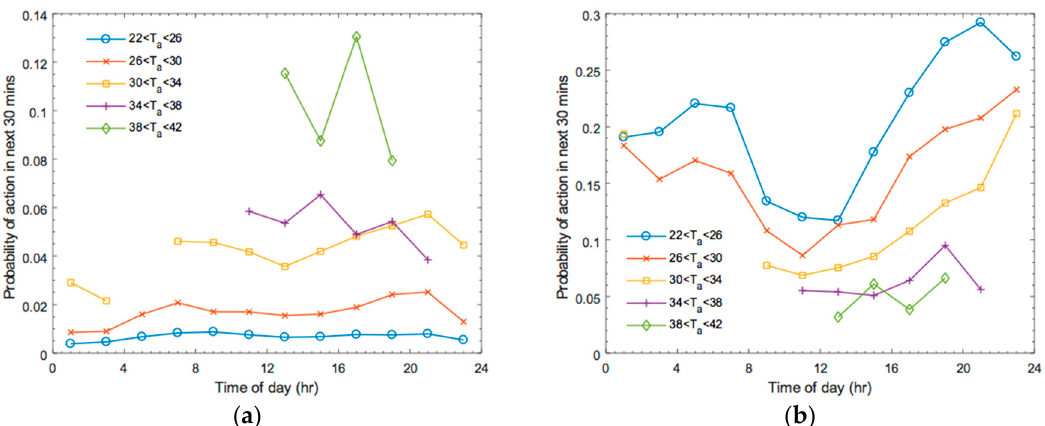
Figure 6. Probability of air-conditioner “switch on” action ( a ) and “switch off” action ( b ) as a function of time of day separated by apparent ambient temperature (T app ).